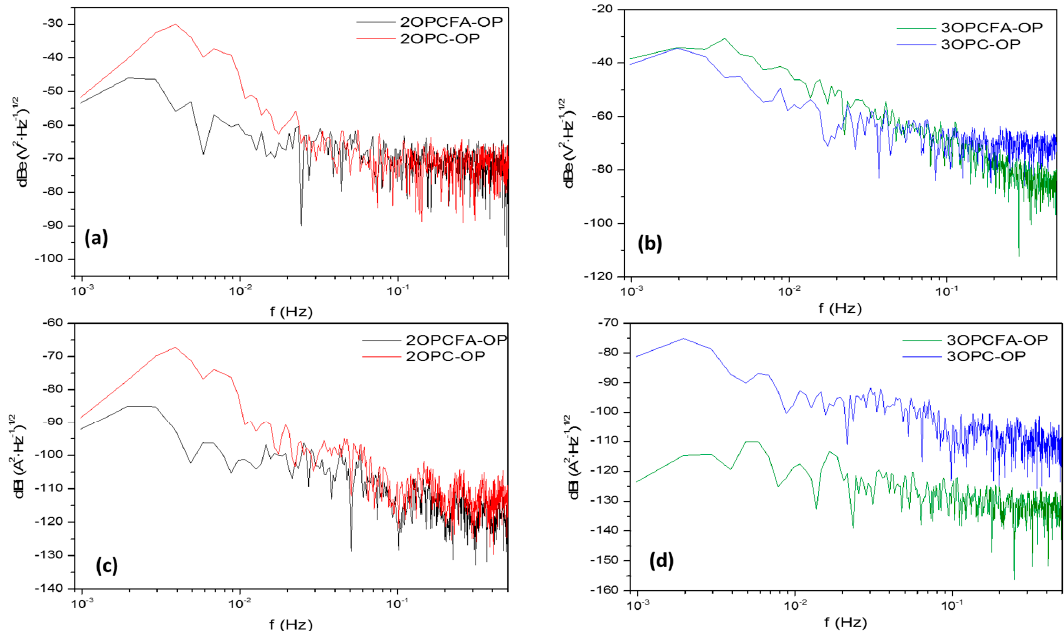
Figure 7. Power spectral density (PSD) for specimens subjected to Impressed current cathodic protection of reinforced concrete mixtures (OPC-OP and OPCFA-OP). ( a , b ) ENP, 2 and 3 months, ( c , d ) ENC, 2 and 3 months. Table 7. Parameters obtained by PSD for reinforced concrete mixtures (OPC-P/OP and OPCFA- P/OP).